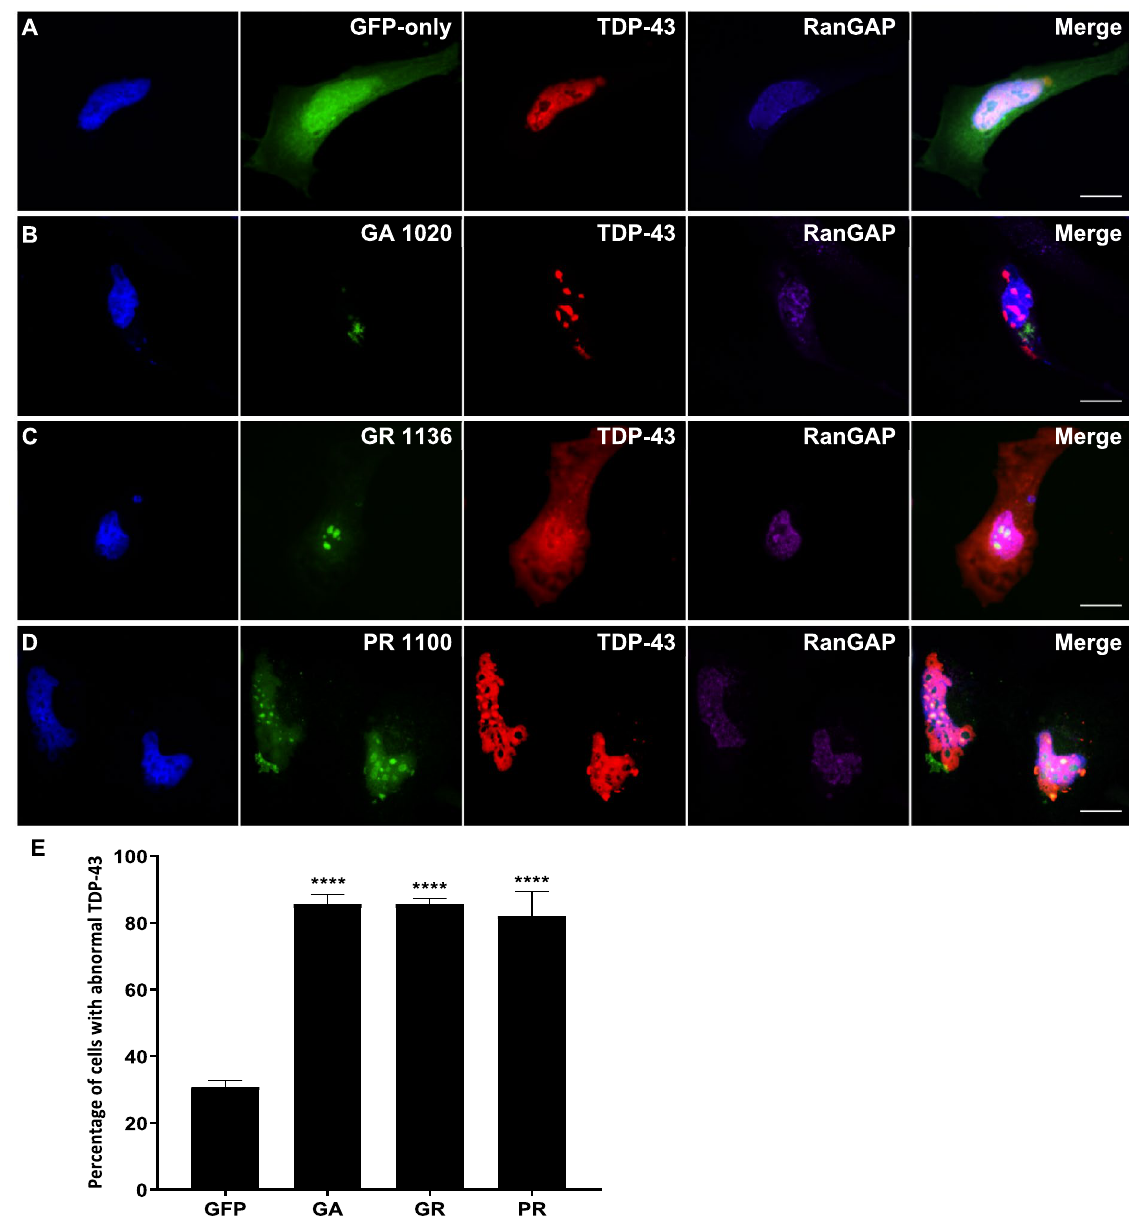
Figure 6. DPR-induced mislocalisation of TDP-43 and RanGAP occur together. ( A – D ) HeLa cells co-transfected with mCherry-tagged human TDP-43 (red) and GFP-tagged DPR constructs or empty pEGFP-N1 vector as a GFP-only control were fixed and stained 48 h post-transfection. RanGAP was stained using a Cy5-conjugated antibody (purple). Cells exhibiting DPR-induced TDP-43 mislocalisation typically also exhibited granular accumulation of RanGAP in the nucleus. Scale bars indicate 15 μm. ( E ) The mean percentage of cells with abnormal TDP-43 that also exhibited granular accumulation of RanGAP in the nucleus was significantly increased by GA 1020 ( P < 0.0001) , GR 1136 ( P < 0.0001), and PR 1100 ( P < 0.0001). n = 3, with a minimum of 30 cells analysed for each independent replicate. Data was analysed by one-way ANOVA with Dunnett’s multiple comparison test. Error bars indicate